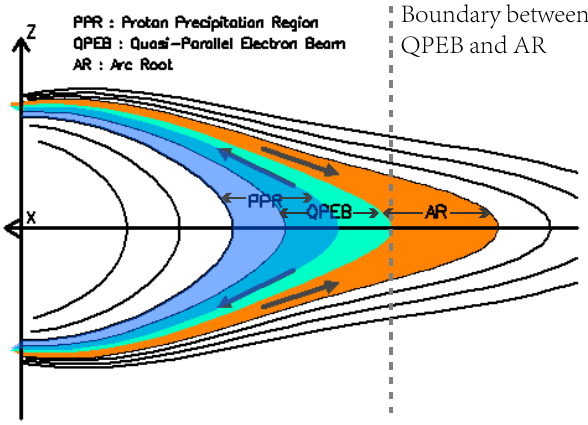
Fig. 2. Schematic diagram showing the magnetospheric regions of our interest, including the proton precipitation region, the QPEB region, and the AR. Solid arrow indicates the sense of FAC in each region. A vertical line highlights the core observational interest in this study: a boundary between the upgoing electron beam and arc in the ionosphere, or equivalently a boundary between the QPEB and AR in the equatorial